Question: Provide a one-line summary of what is displayed.
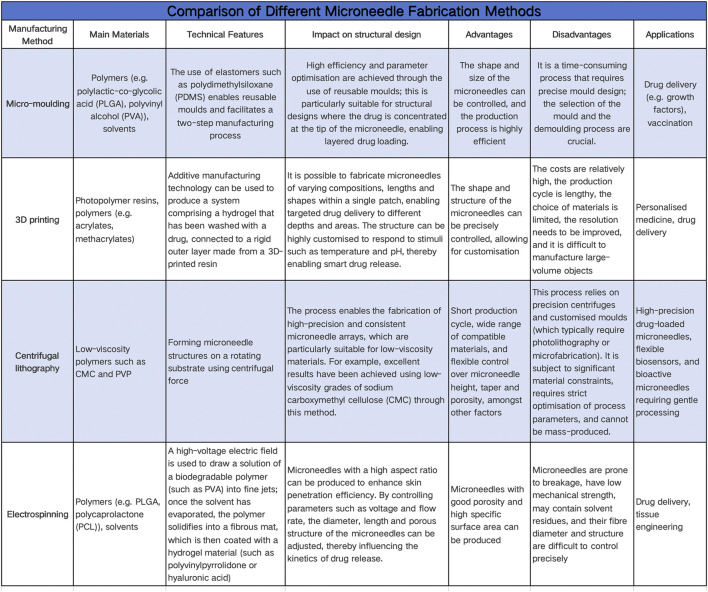
Answer: Shows a comparison of different microneedle preparation methods.